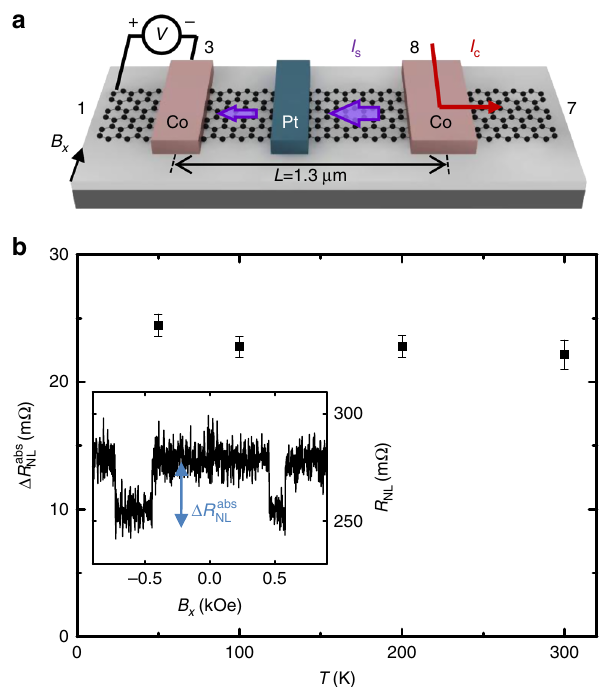
Fig. 3 Spin absorption by Pt in a trilayer graphene lateral spin valve. a Sketch of the measurement con fi guration, including the electrodes from Fig. 1b that are used, and the direction of the applied magnetic fi eld ( B x ). b Spin signal after Pt absorption Δ R abs as a function of temperature. Inset: non NL local resistance as a function of B x measured with I C = 10 μ A and center-to- center Co electrode spacing L = 1.3 μ m in the con fi guration shown in a , from which the values of Δ R abs are extracted for different temperatures. The NL curve shown corresponds to 50 K. Error bars are calculated using the standard errors associated with the statistical average of the nonlocal resistance in the parallel and antiparallel